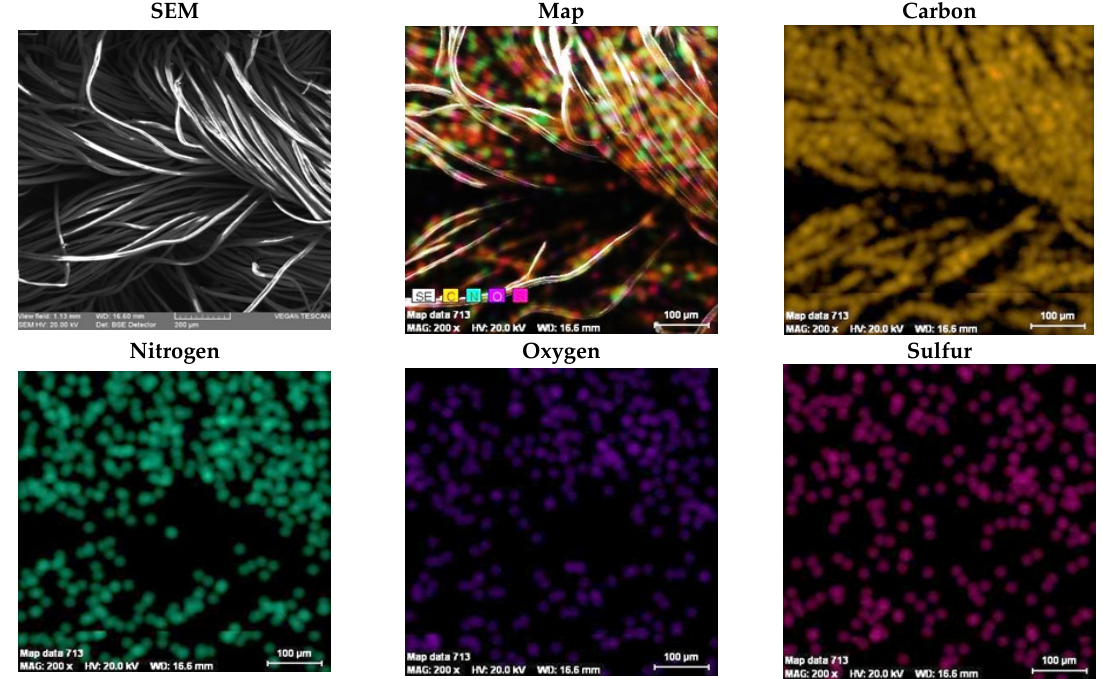
Figure 8. SEM image and element mapping in untreated Melana fibers.